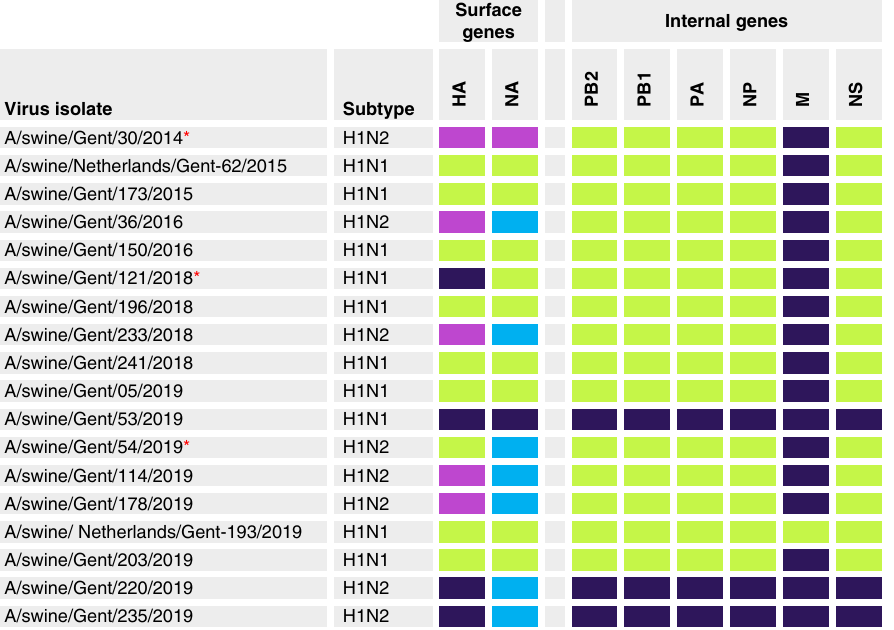
Figure 1. Genotypes of 18 H1N1 and H1N2 swIAV isolated in Belgium and the Netherlands between 2014 and 2019. The colour coding assigned to gene segments is based on their origin: green rectangle European avian- like H1N1, magenta rectangle European human-like H1N2, dark blue rectangle 2009 pandemic H1N1, light blue rectangle human-like H3N2. The N2 of the isolates originated either from the European human-like H1N2 lineage (swSC94-like; purple rectangle) or from the European human-like H3N2 lineage (swG84-like; light blue rectangle) 21 . The three viruses with new genotypes are shown with asterisks